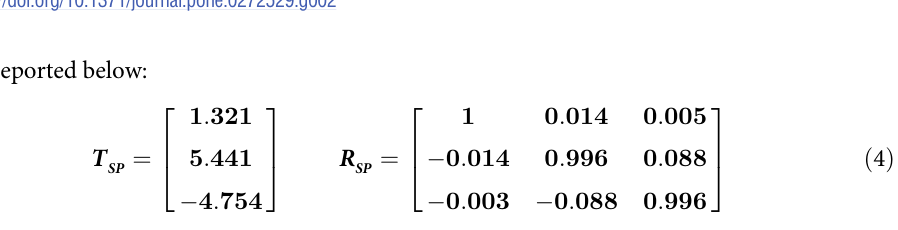
Fig 2. Workflow used to compare predicted and experimental local displacements. a) Registration of the DIC points (red surfaces) to the segmentation obtained from the CT data. By aligning the surfaces, it was possible to perform the comparison between the displacements predicted by the FE model and the ones measured using the DIC. b) Boundary conditions applied to the FE model: the inferior surface of the lower vertebral body was fixed while translations (T SP ) and rotations (R SP ) are applied through a pilot node SP to the superior surface of the upper vertebral body. c) Illustration of the tool used for the local displacement